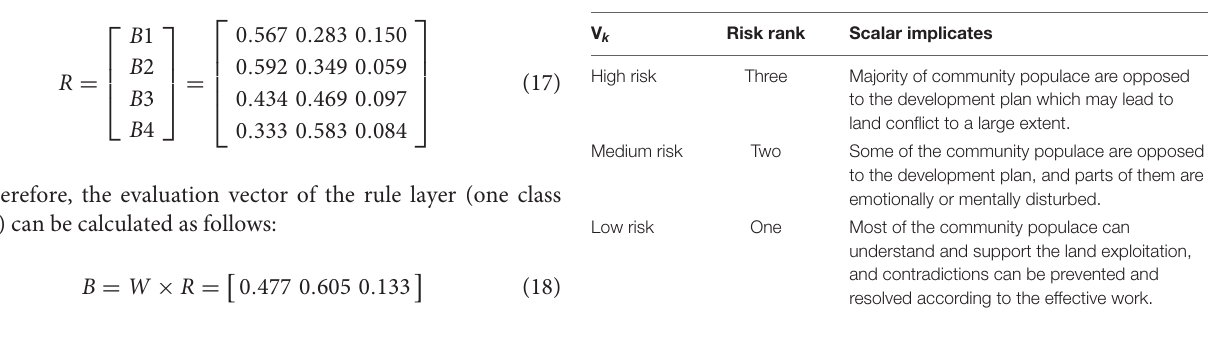
TABLE 3 | The risk assessment grading of land